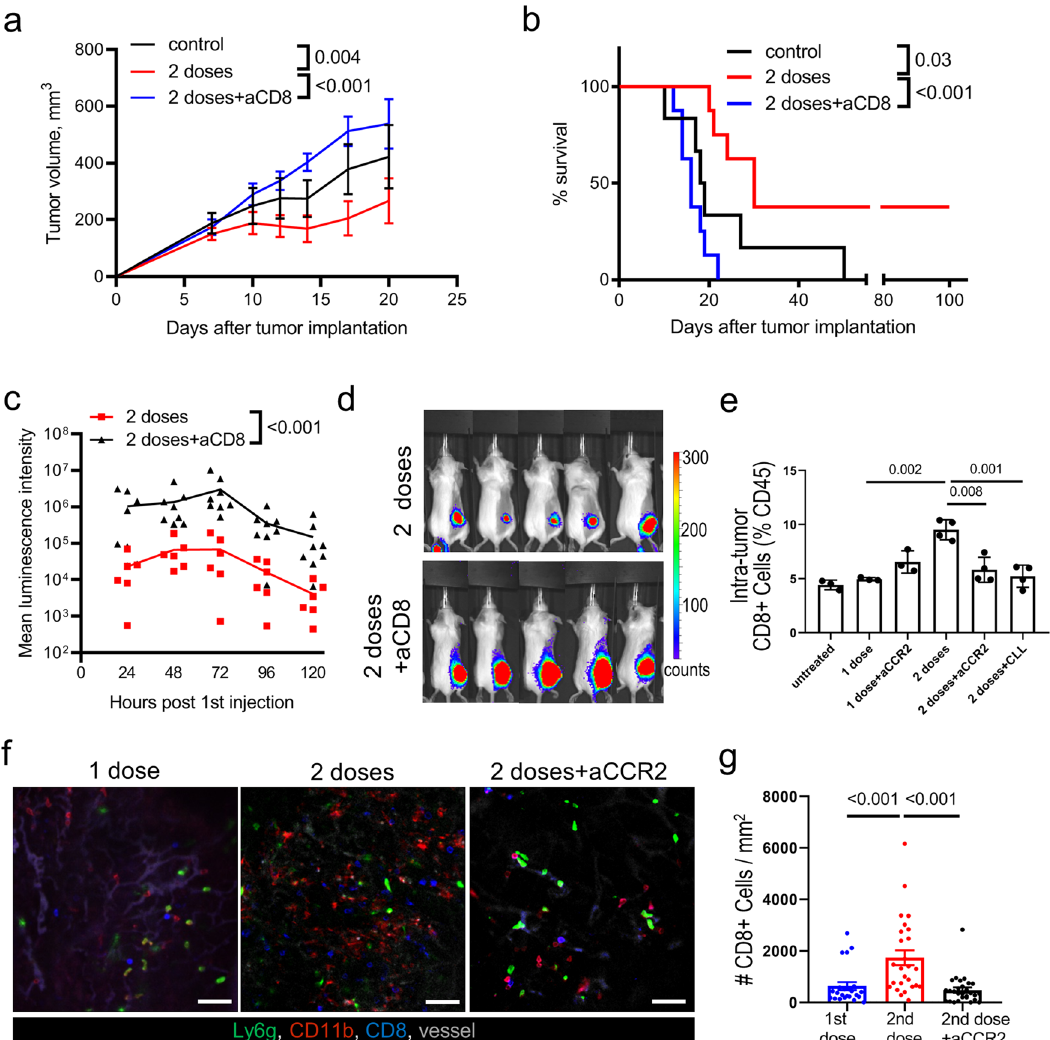
Fig. 5 OV-monocyte interactions promote CD8 + T cell recruitment. a Tumor measurements for untreated CT26 LacZ -bearing animals and mice